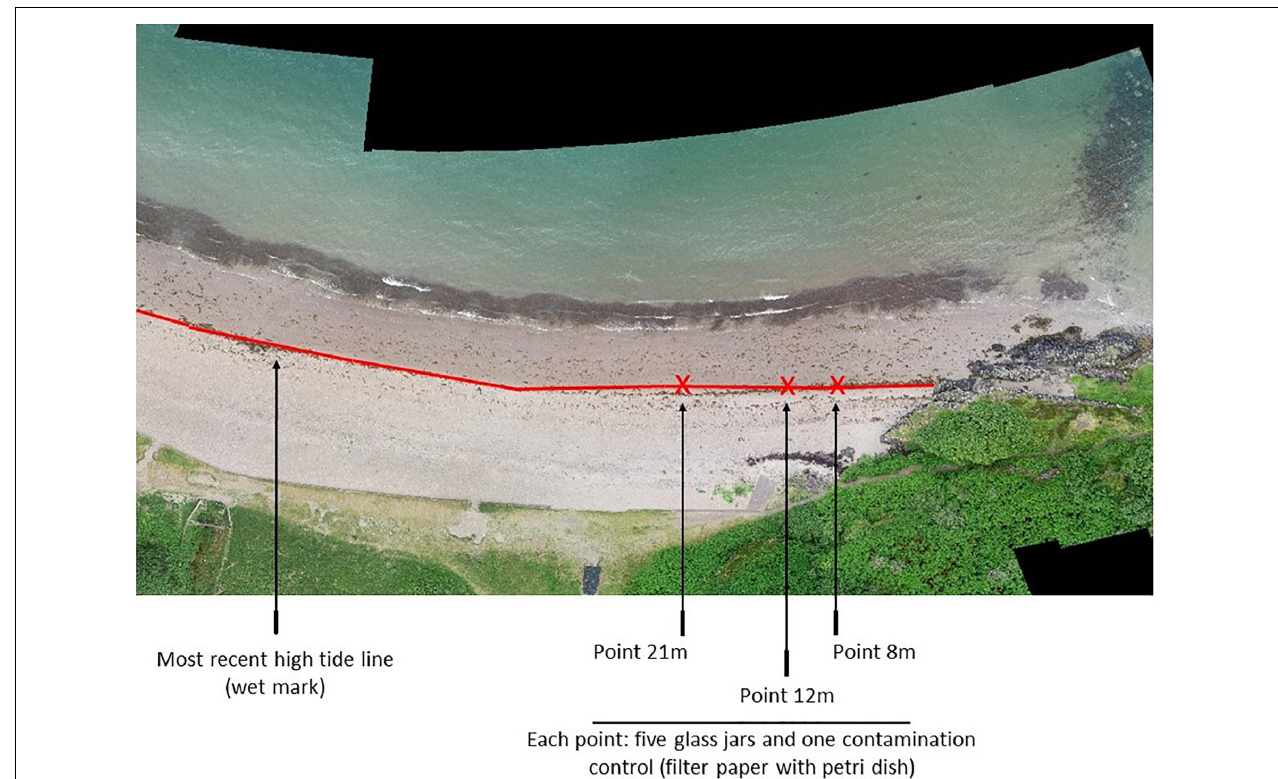
FIGURE 3 | Collection of intertidal sediment at the most recent high tide line displaying the three points on Ganavan sands beach. The red line indicates the high tide line.